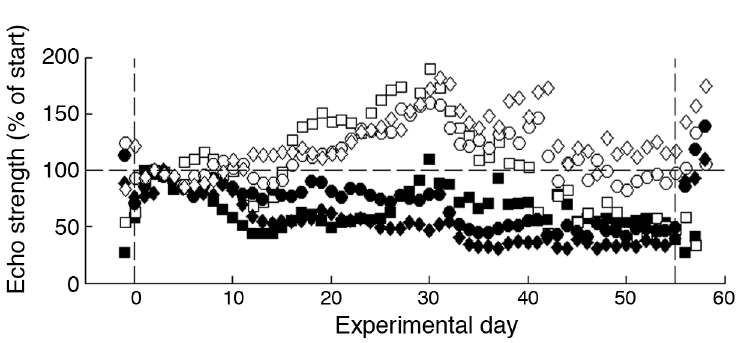
Fig. 5. Total echo strength corrected for biomass (TS corr ) in Atlantic salmon as a percentage of the initial total echo strength prior to snorkel installation given as means (±SE) d −1 for the 3 snorkel and control cages over the 58 d experimental period for Expt 2. Open symbols: replicate control cages; filled symbols: replicate snorkel cages